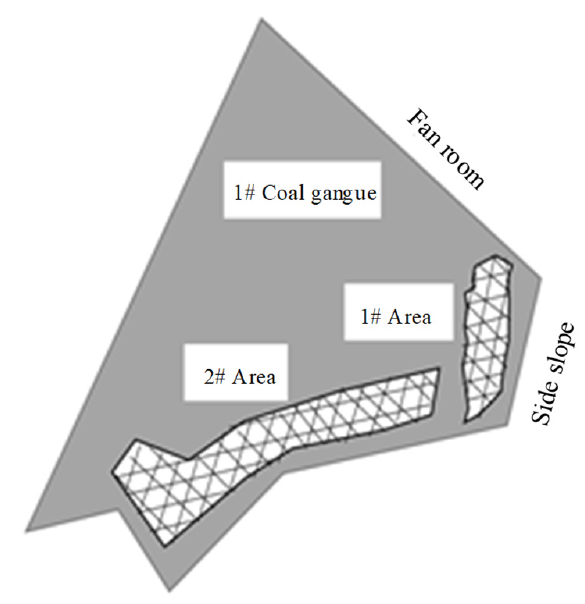
Figure 9. Grid division of surface anomaly area.